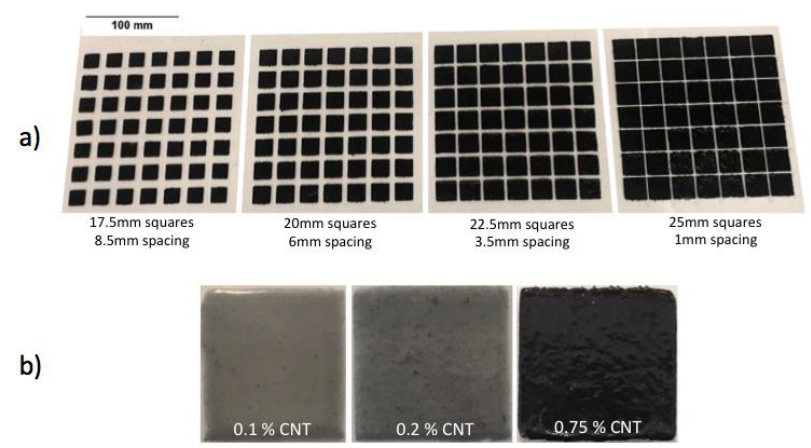
Figure 2. ( a ) Carbon nanotube (CNT) / EA9396 0.75% samples fabricated with diverse dimensions and ( b ) visual comparison of CNT / EA9396 single square composites with 0.1, 0.2, and 0.75% CNT loading.